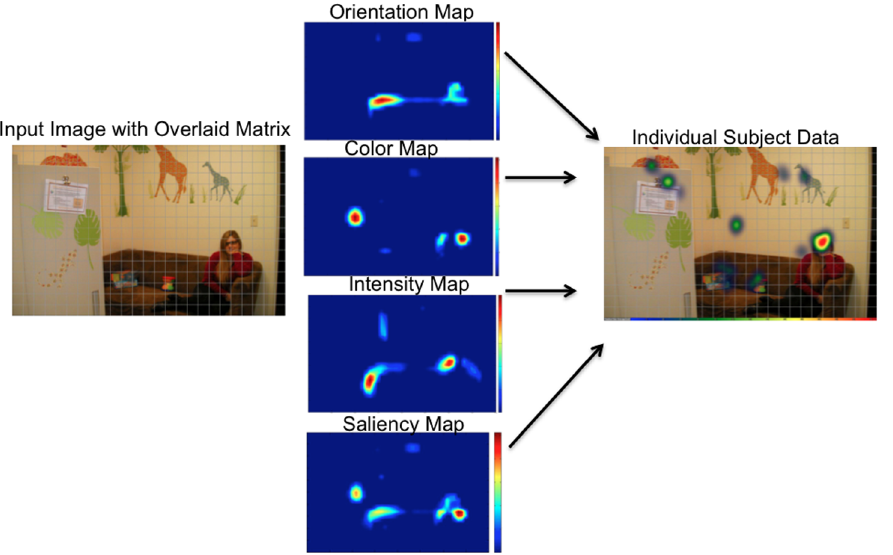
Figure 2. Illustrates the beta coefficient analytic strategy. Each input image was divided into a 16x25 matrix. Saliency and visual feature maps were extracted for each matrix grid location (MGL) and then used as predictors in multiple regression analyses, in order to determine their explanatory power for the duration of looking variable in those MGLs, per participant and image.